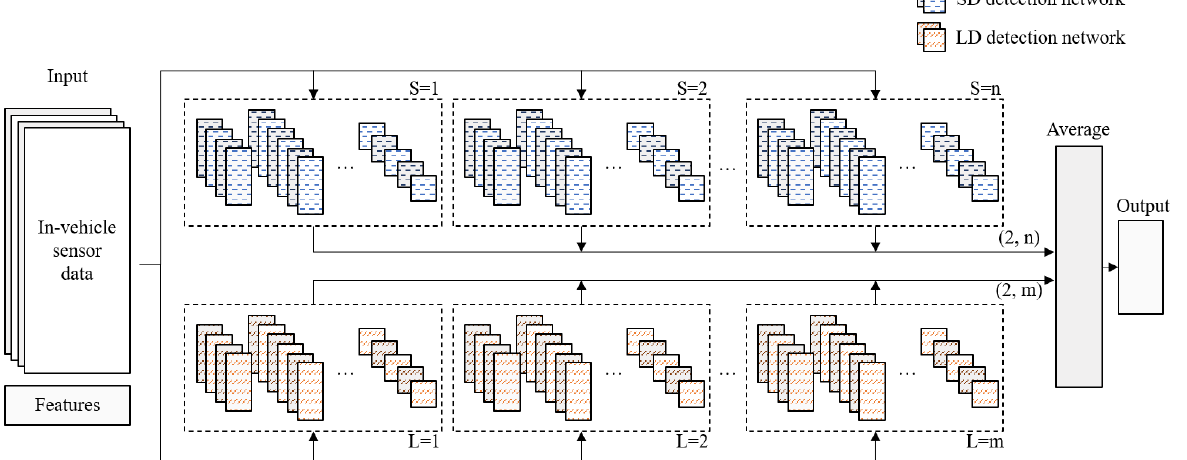
Figure 5. Proposed ensemble convolution neural network (CNN)